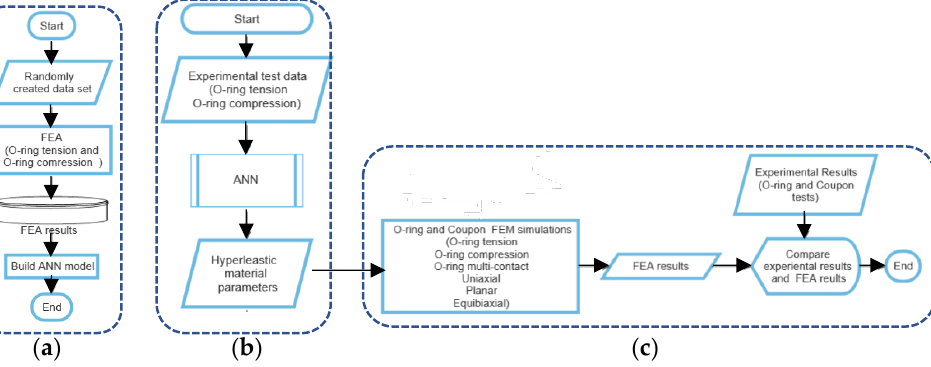
Figure 1. Flow charts: ( a ) ANN-subroutine, ( b ) parameter identification, and ( c ) validation steps.